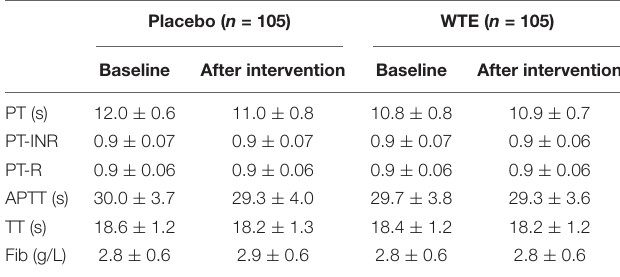
TABLE 4 | Effects of WTE on coagulation function in healthy middle-aged and older individuals. Placebo ( n = 105) WTE ( n = 105) Baseline After intervention Baseline After